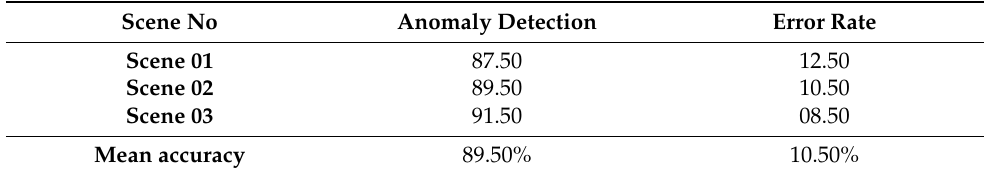
Table 5. Confusion matrix of proposed EPB method over UMN